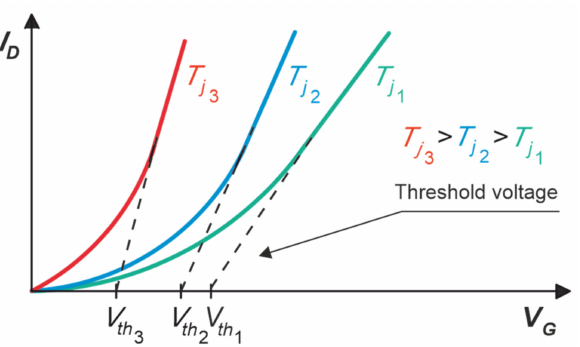
Figure 5. Method to determine the value of threshold voltage V th and the dependence of V th on the die temperature T j .